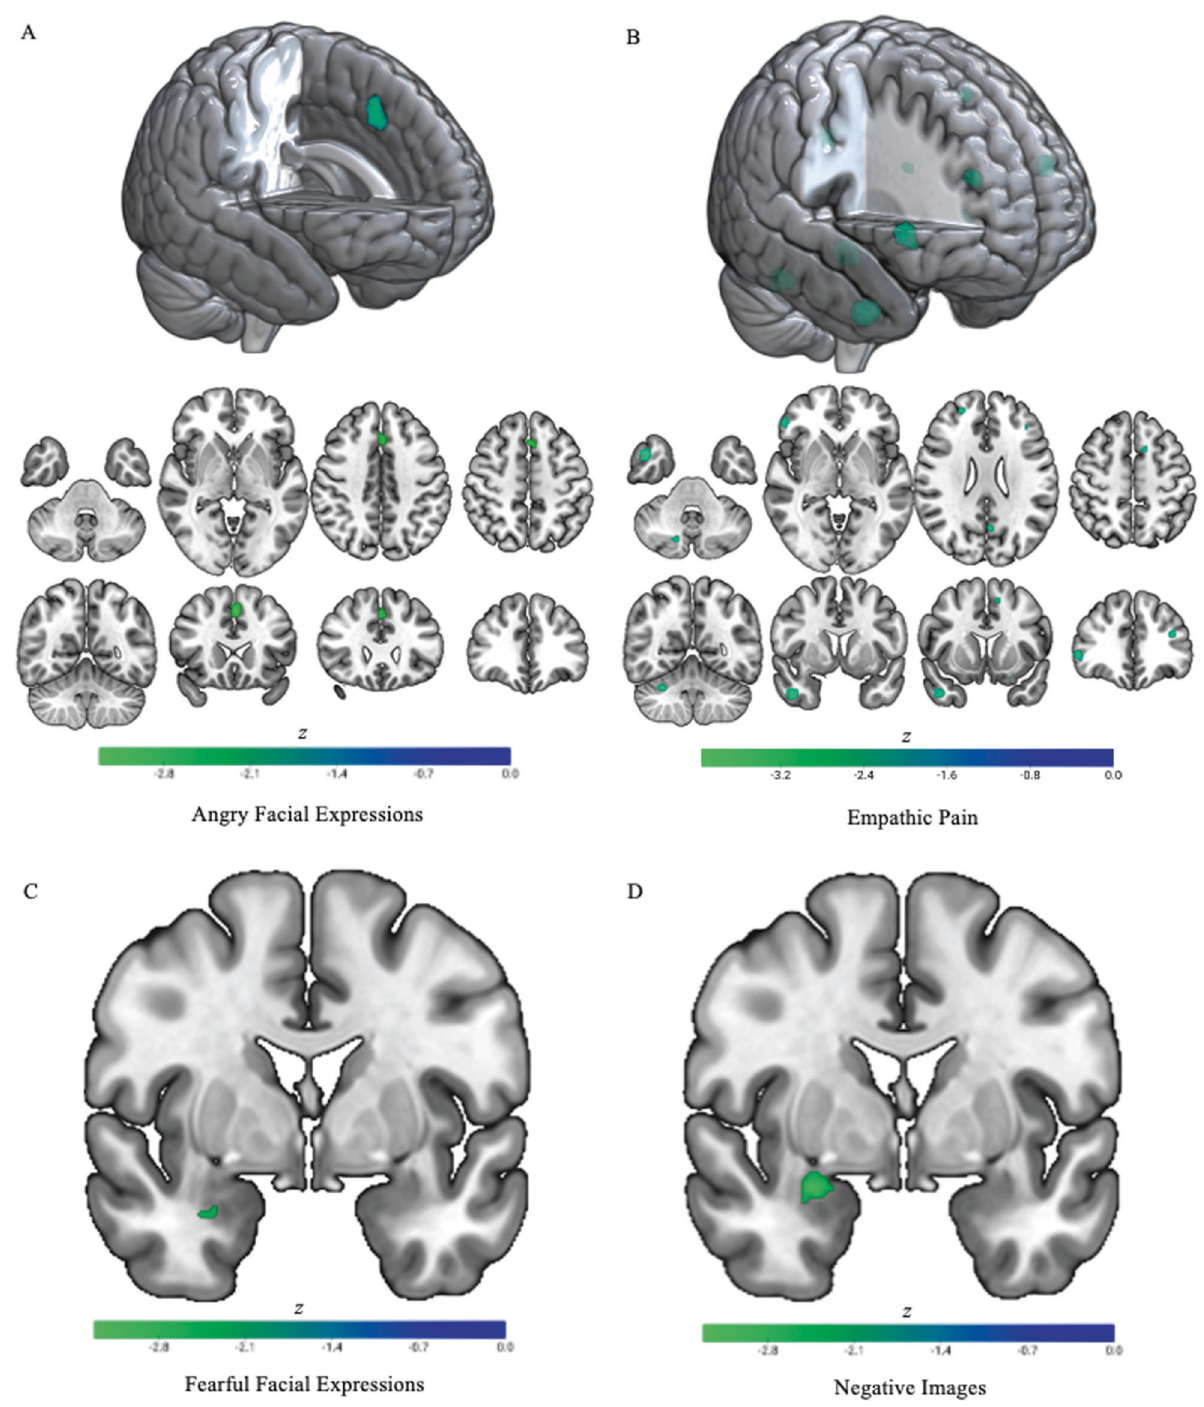
Fig. 2 Regions reduced in youths with conduct problems relative to healthy control youths in whole-brain and ROI fMRI meta-analyses by task domain. A Whole-brain results on angry facial expressions. B Whole-brain fi ndings on empathic pain responses. C Results from the amygdala region of interest analysis on fearful facial expressions. D Results from the amygdala region of interest analysis on negative images. The right side of the image corresponds to the left side of the brain. frontal gyrus (Table 2 and Fig. 2). ROI analyses were not FWER-correction, including a region that spanned right temporal conducted due to a lack of suf fi cient available studies ( n = 1). pole and included areas of middle and inferior temporal gyrus in which youths with conduct problems showed reduced activa- tion (Fig. 2). Regions in which uncorrected group differences Group differences for empathic pain images emerged included one region, left hippocampus, in which The whole-brain meta-analysis of responses to empathic pain youths with conduct problems showed increased activation images included 3 contrasts (Table 2). Three regions survived Translational Psychiatry (2023)